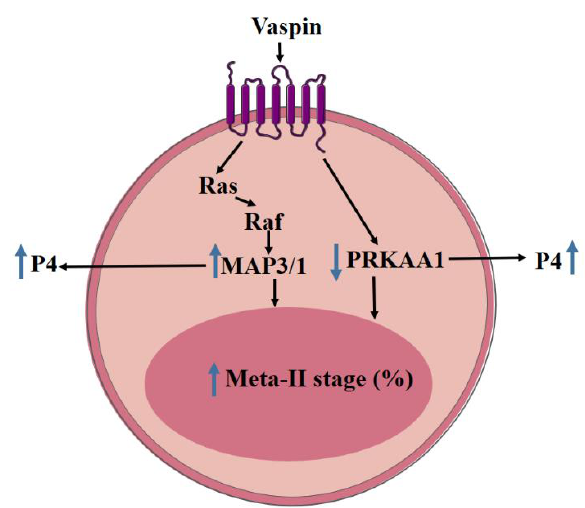
Figure 5. Model of the action of vaspin on in vitro porcine oocyte maturation. Vaspin stimulates oocyte nuclear maturation as well as progesterone (P4) secretion by activation of mitogen-activated kinase (MAP3 / 1) and inhibition of AMP-activated kinase (PRKAA1); metaphase-II of meiosis (meta-II); ↑ increase; ↓ decrease.